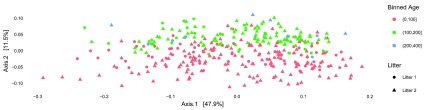
The sample positions produced by a PCoA using weighted Unifrac.